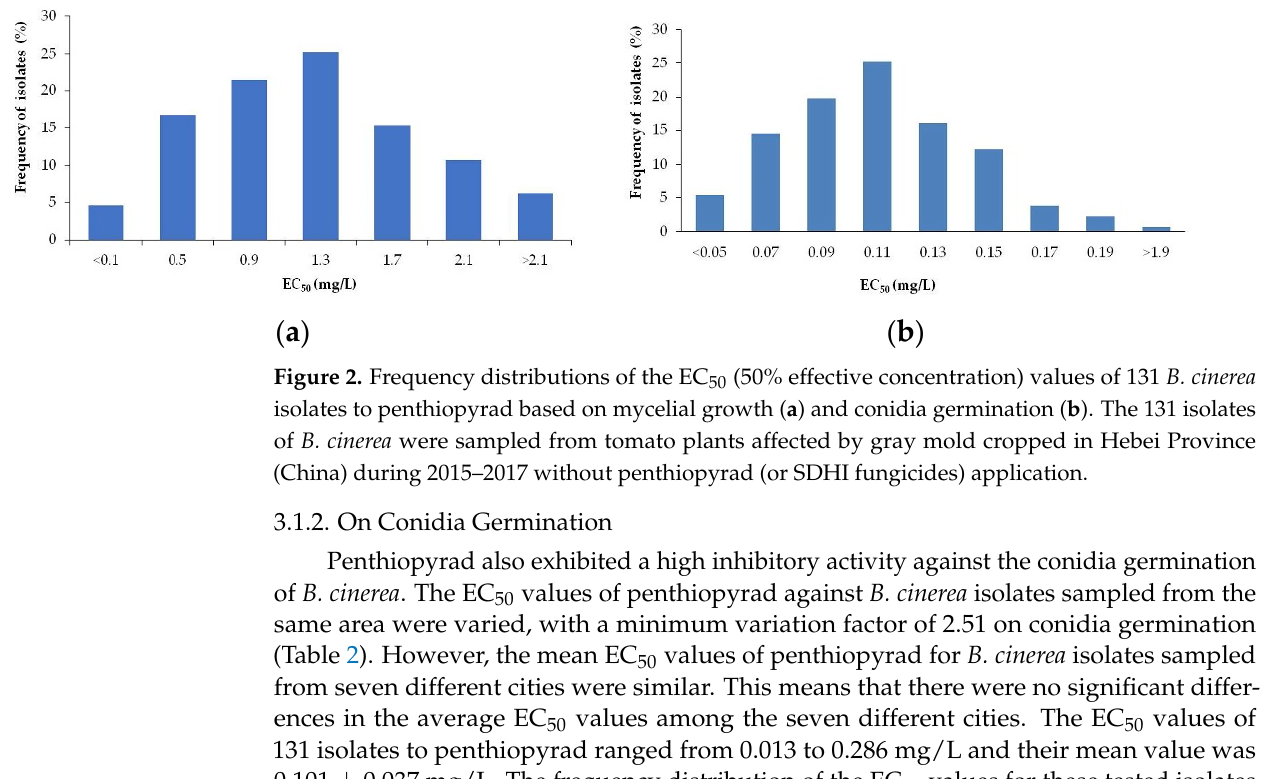
Table 2. Sensitivity baseline to penthiopyrad of 131 Botrytis cinerea isolates sampled from tomato plants affected by gray mold cropped in Hebei Province (China) during 2015–2017 without SDHI fungicide application.